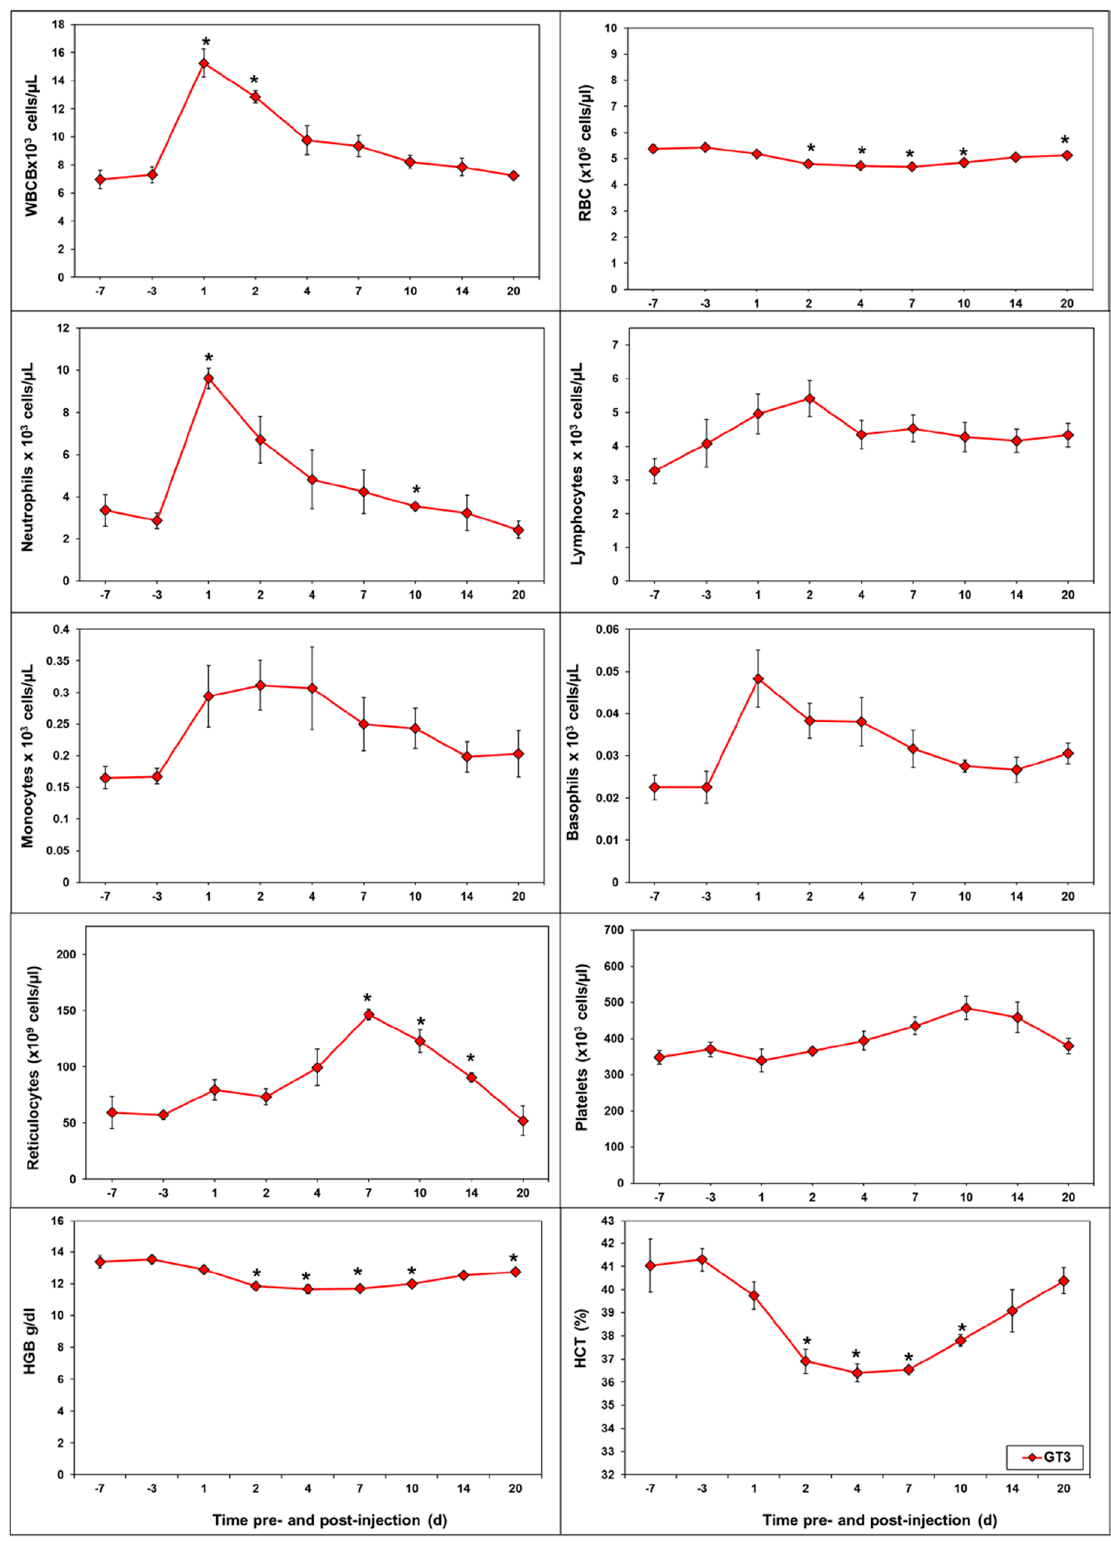
Figure 5. GT3-induced changes in complete blood counts as well as differential counts. GT3 was injected (subcutaneous, sc) to NHPs. Blood was collected at various time points. Cells were counted using a Bayer Advia-120 cell counter. The data for each time point is presented as the mean ± standard error. The difference between GT3-treated doses (average of all doses) and their respective baseline measurements (average of pre-irradiation values on SD-7 and -3), when significant ( p ≤ 0.05), is indicated with “ *